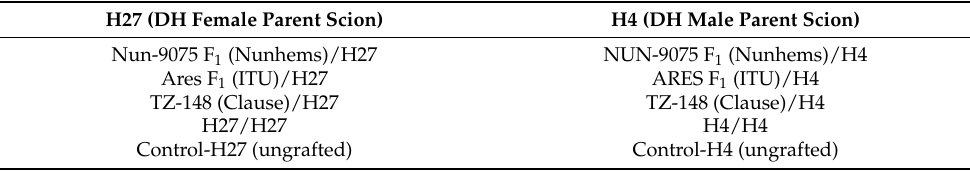
Table 1. Plant material use in the